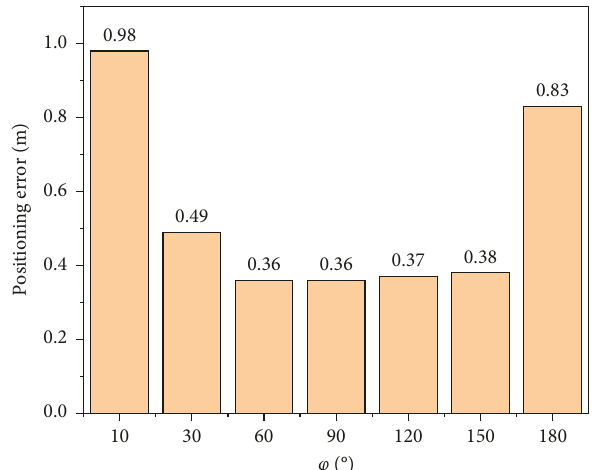
Figure 3: Histogram of the influence of phase offset threshold φ on positioning.